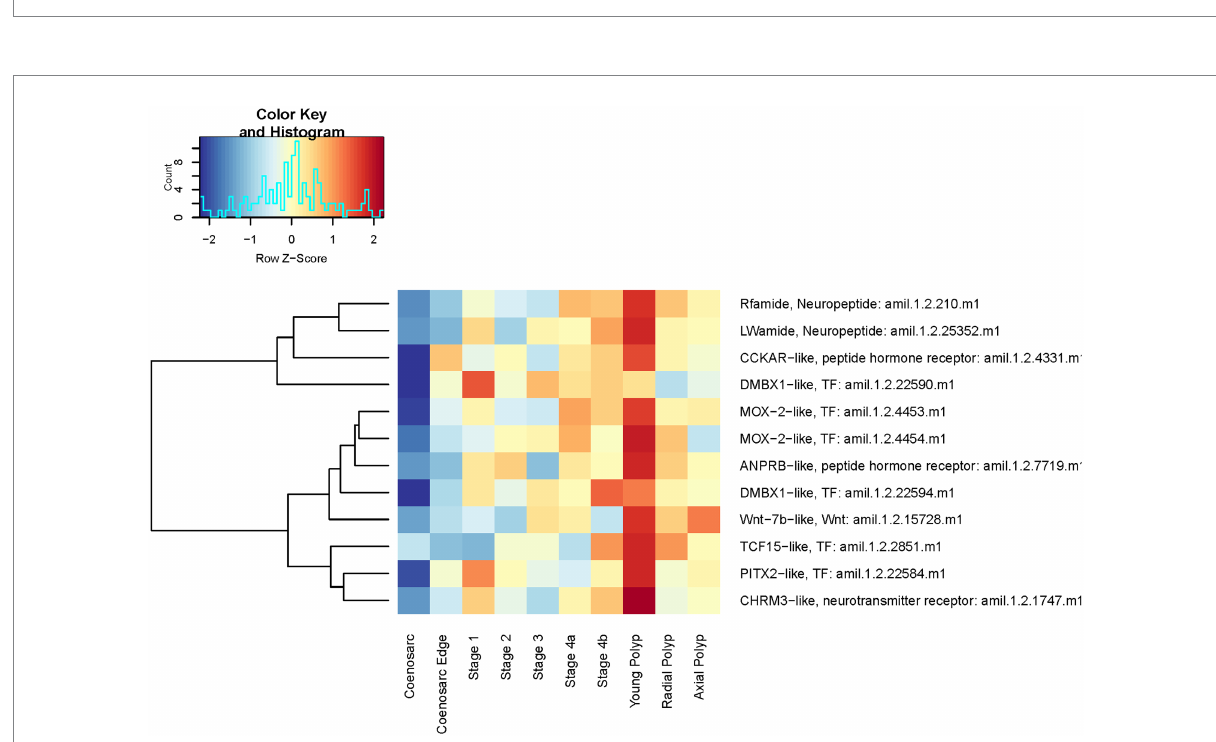
FIGURE 10 Expression heatmap of selected genes identified as upregulated in recently formed (young) polyps of A. millepora . Samples are pooled according to regeneration stage and morphologically distinct colony part. Colour denotes an increase (red) or decrease (blue) in expression based on the z-score. The Histogram shows the distribution of the z-scores on the